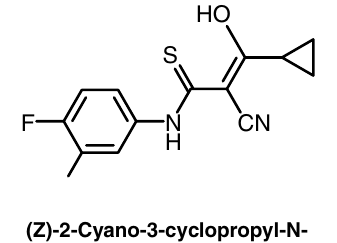
Figure 1. The structure of